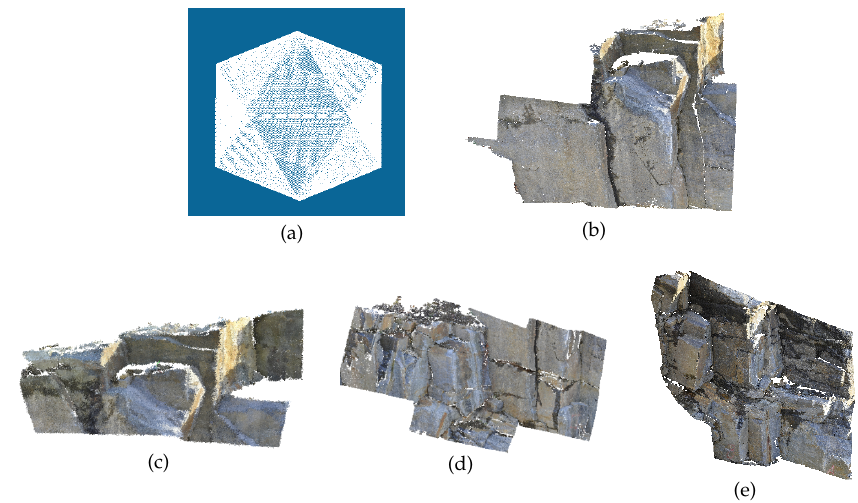
Figure 7. Five datasets. ( a ) Icosahedron; ( b ) Rock1; ( c ) Rock2; ( d ) Rock3; ( e ) Rock4.